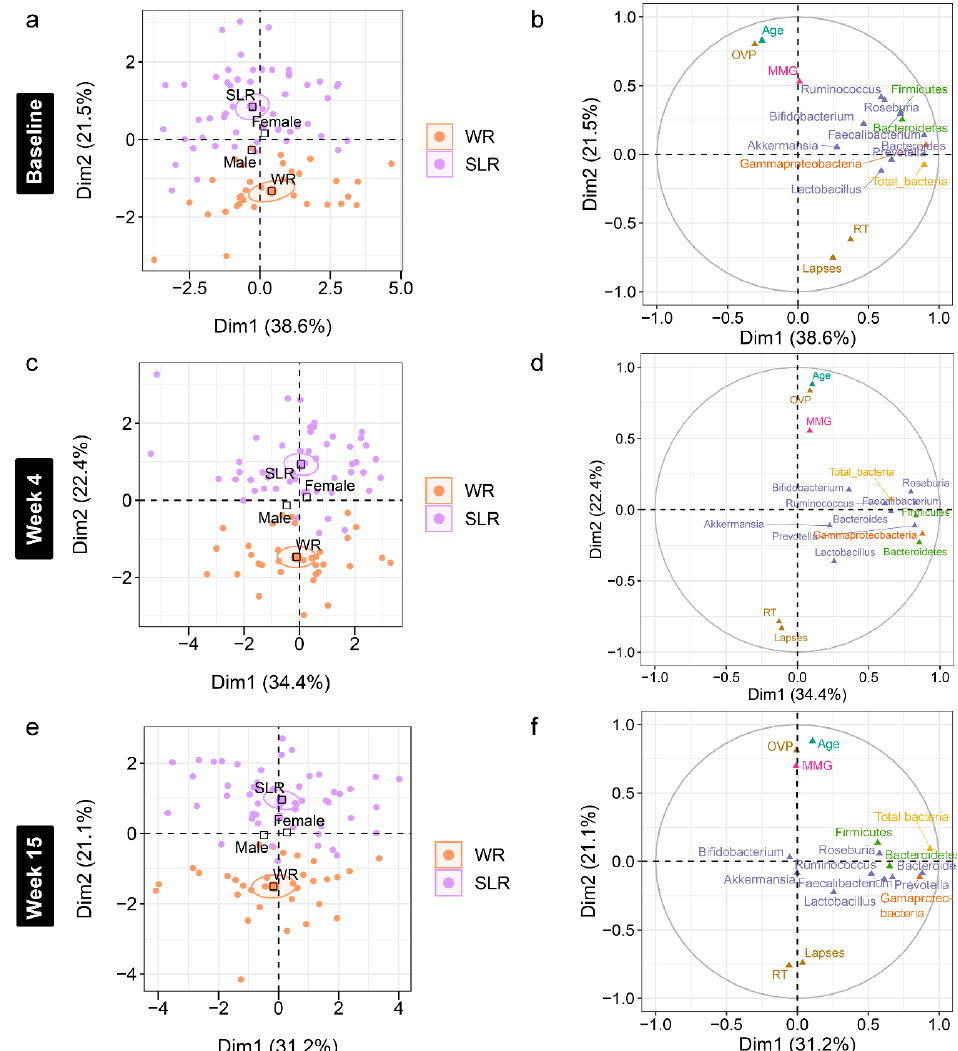
Figure 6. Multiple factor analysis (MFA) of variations in the gut microbiota and cognitive performance of school-aged children explained by the intervention, gender, and age in Phase I. ( a , c , e ) Individual factor maps broken down by the treatment groups (specified by the 95% confidence ellipses) in Dim 1 and 2. ( b , d , f ) Correlation between quantitative variables (gut microbiota at the phylum (green), class (orange), and genus (purple) levels, cognitive performance, and age) and dimensions (Dim 1 and 2). MMG, memory matching game, which denotes Corsi block spans; OVP, overall performance (%); RT, reaction times (millisecond); lapses (millisecond). WR, white rice (control); SLR, Sinlek rice